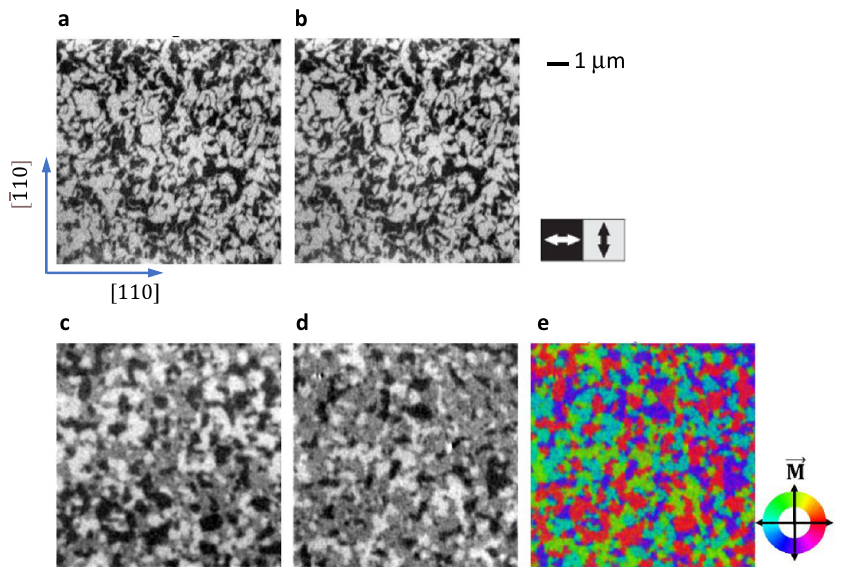
Fig. 4 Magnetic microscopy of as-grown Mn 2 Au(40 nm)/Py(4nm)/SiN x (2 nm). The horizontal and vertical edges correspond to the four easy <110> directions of the epitaxial Mn 2 Au(001) thin fi lm. The fi eld of view is 10 μ m 2 ×10 μ m 2 . a XMLD-PEEM image of the Mn 2 Au AFM domains in the as-grown state. b Corresponding XMLD-PEEM image of the Py FM domains. Both in a and b dark corresponds to N and M F right-left and bright to up-down. c SEMPA image showing the x-component of the FM contrast. d SEMPA image showing the y-component of the FM contrast. e is generated from d and e showing the orientation of M F by a color code, which indicates that M F of the Py domains is pointing parallel to all four easy <110> directions of the Mn 2 Au(001) thin fi lm.